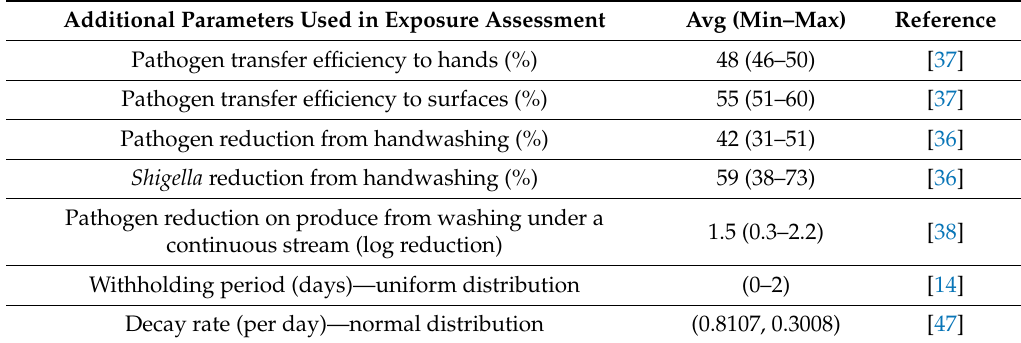
Table A1. Additional relevant parameters associated with best-practice exposure scenarios.